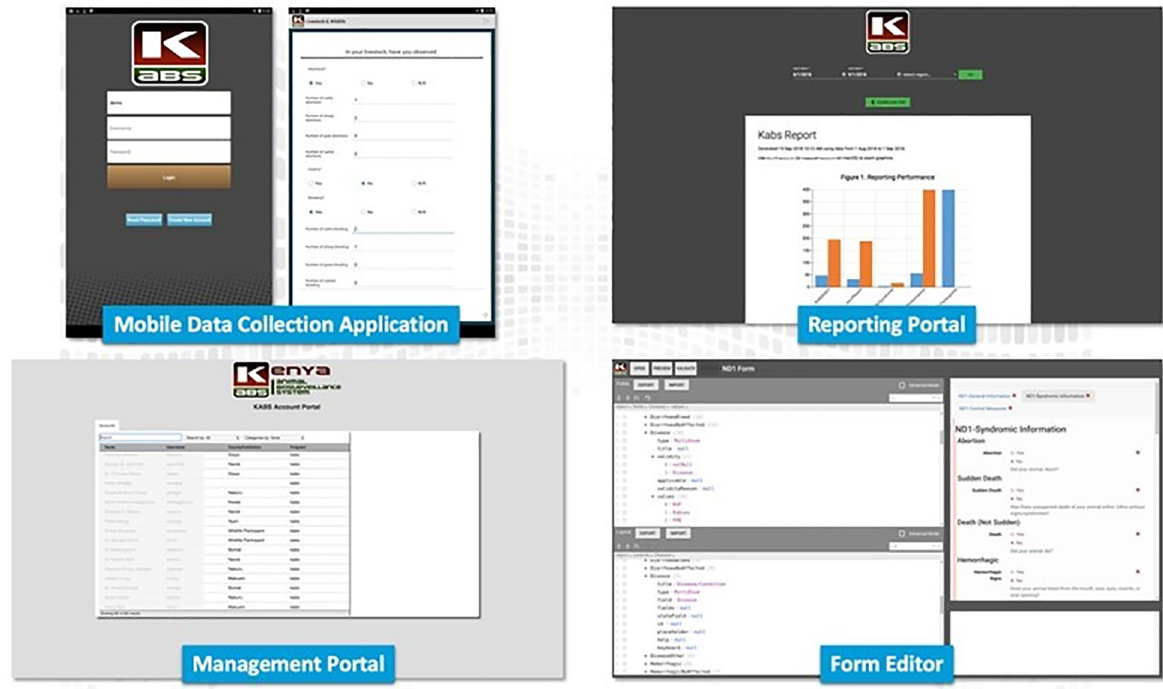
Fig 1. Illustration of the four components of the KABS mobile phone application platform used to report domestic and wild animal disease in Kenya.